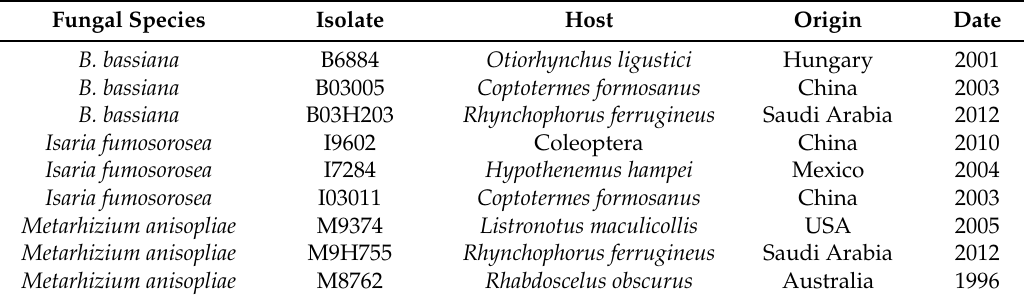
Table 4. Isolates of entomopathogenic fungi used in the